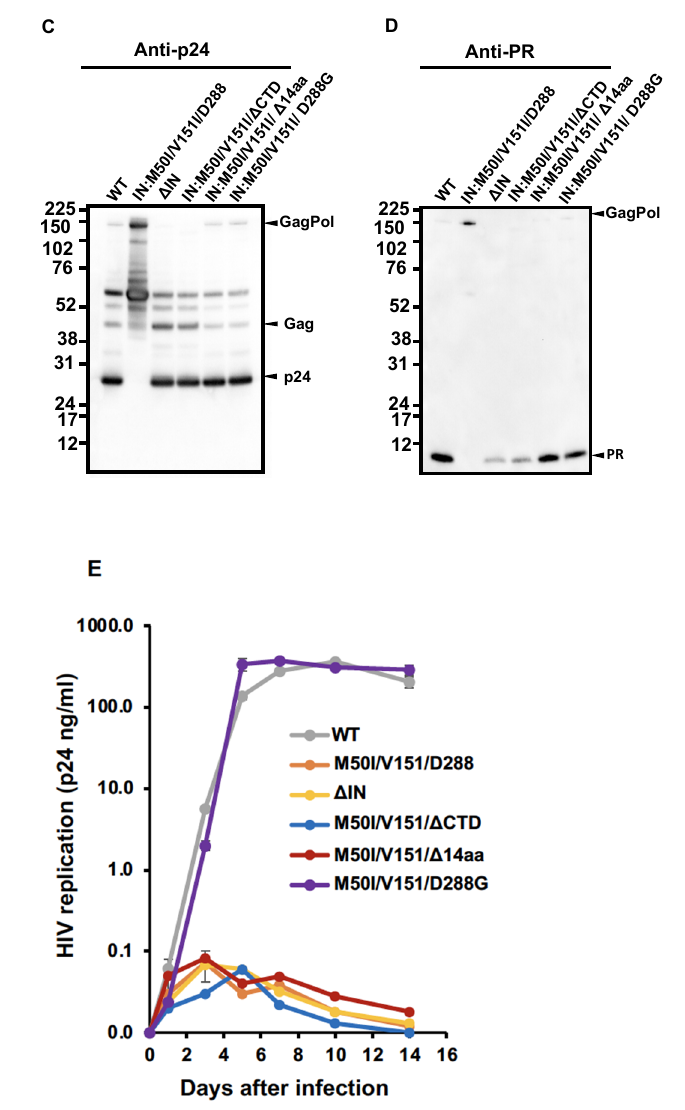
Figure 4. The C-terminal domain of IN regulates virus release and autoprocessing. ( A ) Diagrams indicate the structure of GagPol(WT) and variants. The numbers above the diagrams indicate codon position in IN. Each mutant was created by inverse PCR or site-directed mutagenesis, as described in the Materials and Methods (Section 2.3). MA: matrix protein; CA: capsid protein; NC: nucleocapsid protein; P: protease; RT: reverse transcriptase; RH: RNase H; IN: integrase; N: the N terminal domain of IN; CC: the catalytic core domain of IN; C: the C terminal domain of IN. ( B ) Each construct was transfected into HEK293T cells. Transfection supernatants derived from HEK293T cells were collected, and viral particles were pelleted as described in the Materials and Methods (Section 2.4) Each viral pellet was resuspended in 1/100 of the transfection supernatants in complete culture media. Viral concentration was determined by measuring the HIV p24 antigen by ELISA. Data indicate means ± SE (n = 5), and the statistical analysis was conducted using one-way ANOVA (Prism). ( C , D ) Virus particles are isolated as described in Materials and Methods (Section 2.4), and 1 µ g of viral lysates was subjected to WB. Gag and GagPol-cleaved products and PR were detected by monoclonal anti-p24 ( C ) and polyclonal anti-PR ( D ). ( E ) PHA-stimulated primary CD4(+)T cells from healthy donors were infected with 10 ng p24 amounts of HIV(WT) or variants containing mutations as described in Materials and Methods (Section 2.5). The infected cells were cultured for 14 days with a medium change every 3 to 4 days. HIV replication was monitored using a p24 antigen capture kit. Representative data from two independent assays are presented as means ± standard deviations (SD) (n = 3). *: p < 0.05, **: p < 0.01, ****: p < 0.0001, ns: not significant.